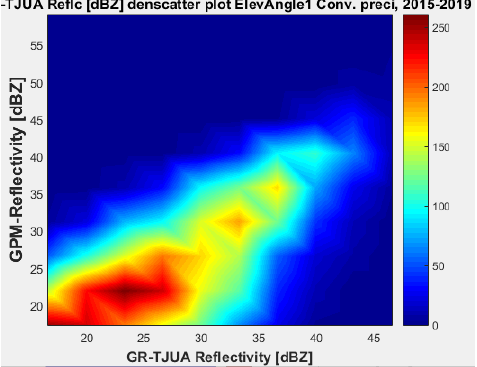
Figure 10. GPM ‐ Ku vs. NEXRAD TJUA for convective precipitation (angle 1).